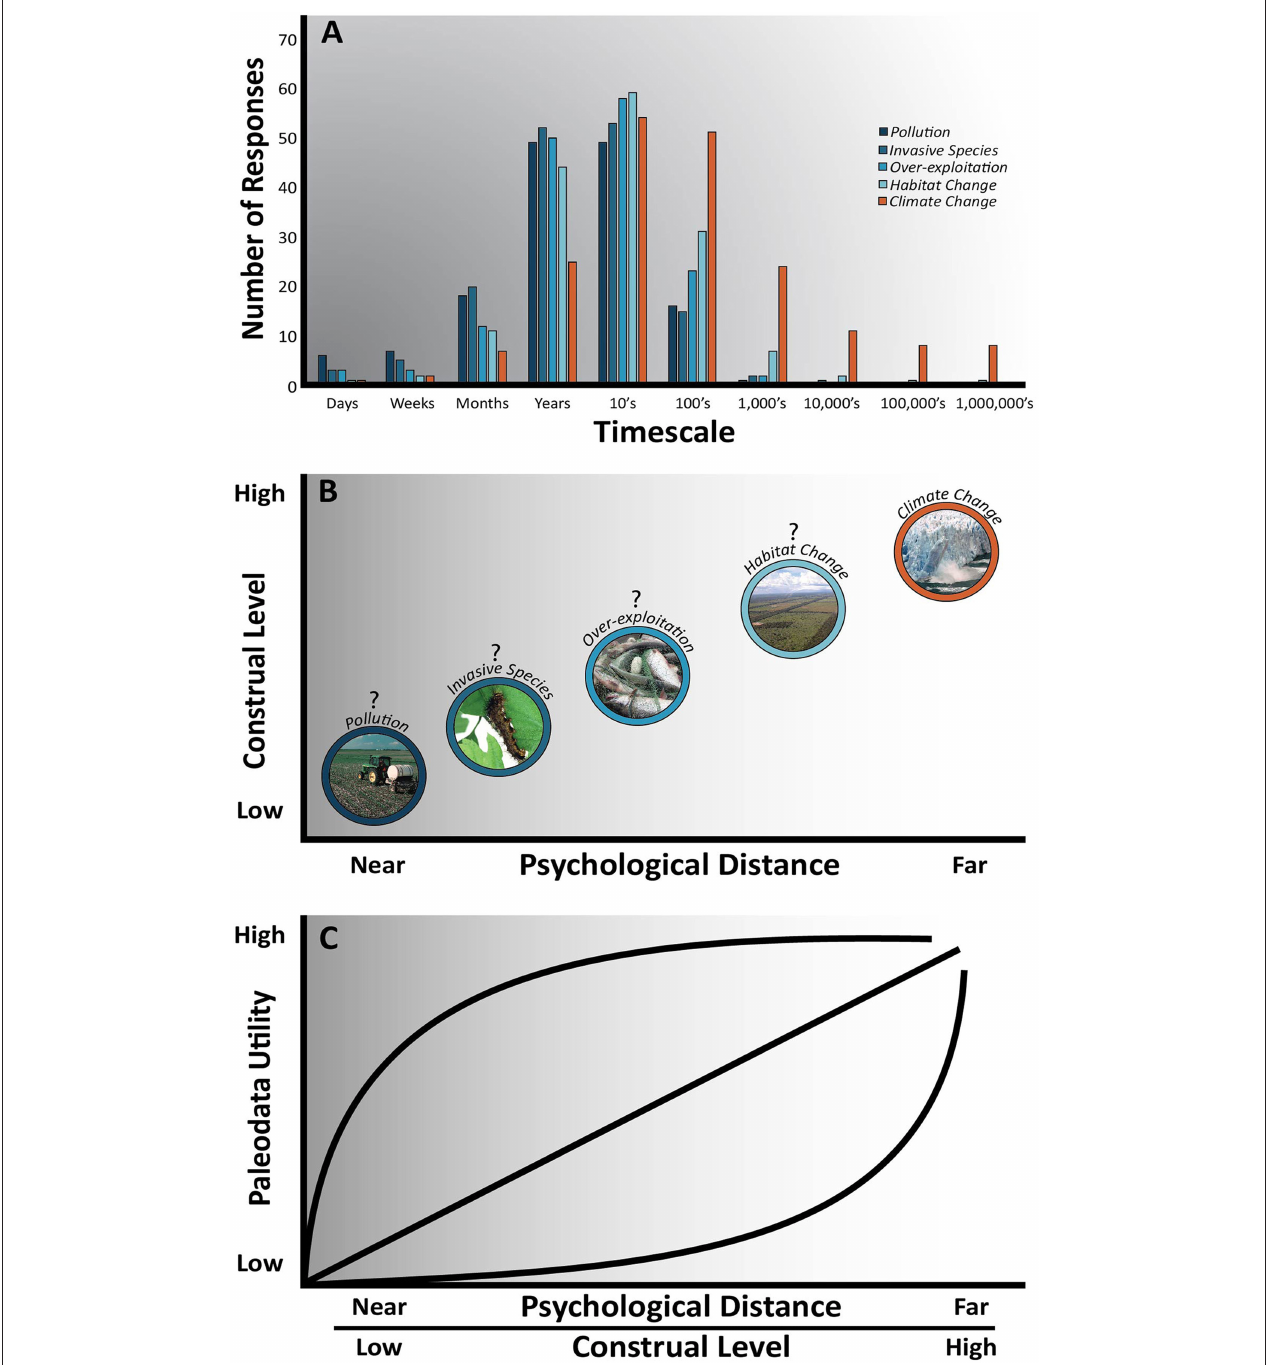
FIGURE 1 | (A) Distribution of timescales necessary to address the five major environmental stressors threatening biodiversity (adapted from Smith et al. (2018) with permission from Springer Nature). For pollution, invasive species, over-exploitation, and habitat change, the response median is between years and decades. For climate change responses, the median is between decades and centuries, with the distribution skewed toward longer timescales (Smith et al., 2018). (B) Hypothetical relationship between construal level and psychological distance for the five major environmental stressors threatening biodiversity today. To our knowledge, no empirical tests of the psychological distance and construal level of the pollution, invasive species, over-exploitation, and habitat change stressors have been conducted. We are most certain in the positioning of climate change at a high construal level and psychologically far distance; the question marks above the other four environmental stressors indicate our uncertainty in their placement. Relative order is based on estimates of the median timescale necessary to address each environmental stressor from the distributions in (A) . (C) Hypothetical relationships between perceived paleodata utility and construal level/psychological distance. Multiple lines indicate our uncertainty in the